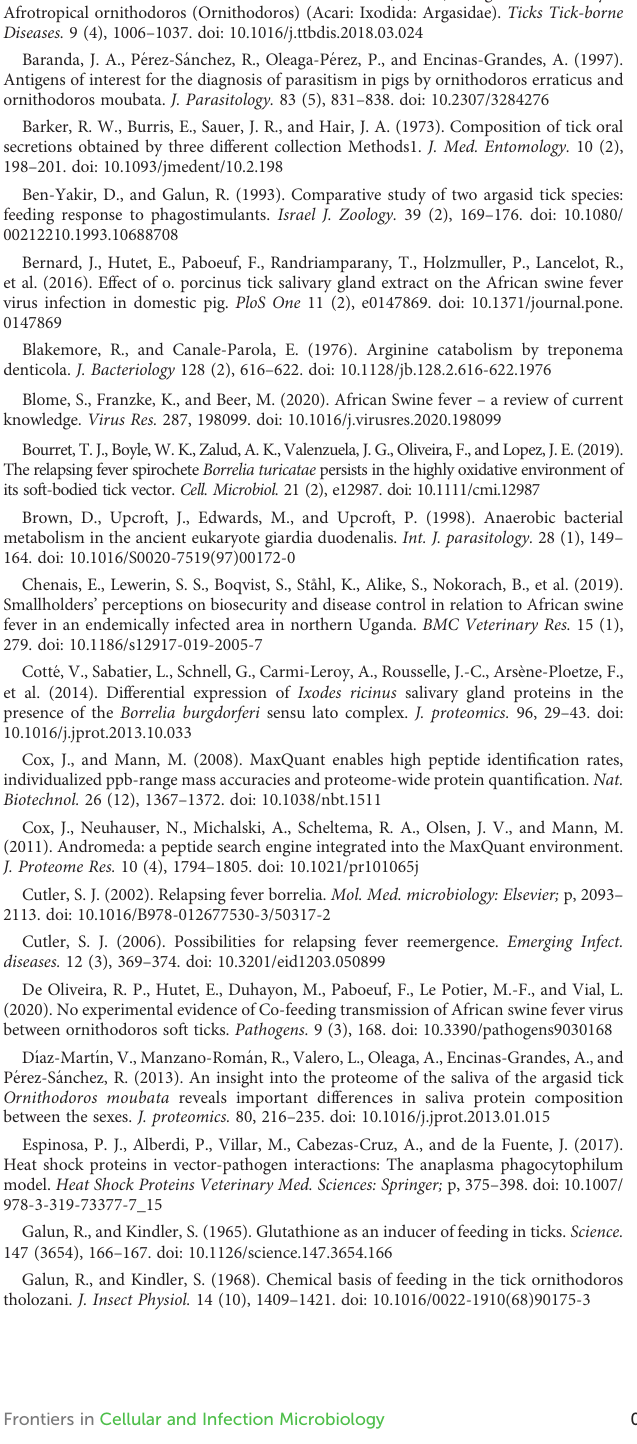
SUPPLEMENTARY FIGURE 1 A heatmap showing the relative intensities (LFQ values) of the detected proteins across the